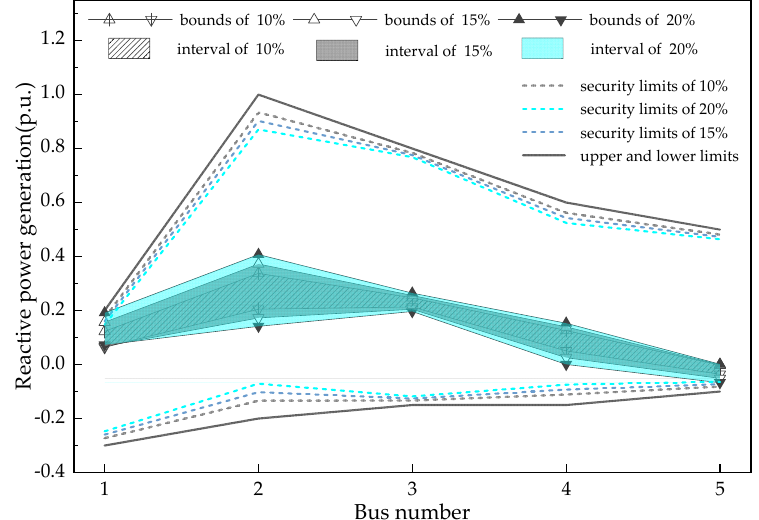
Figure 11. Reactive power generation of generator buses at different tolerances.